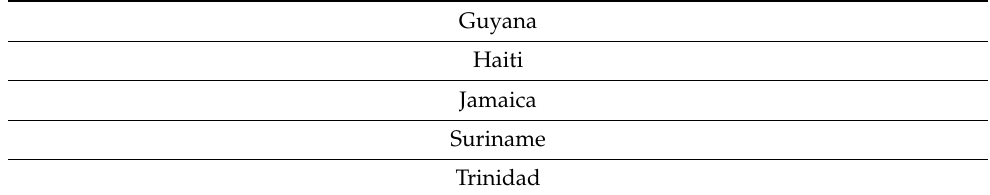
Table A7. The Caribbean—5